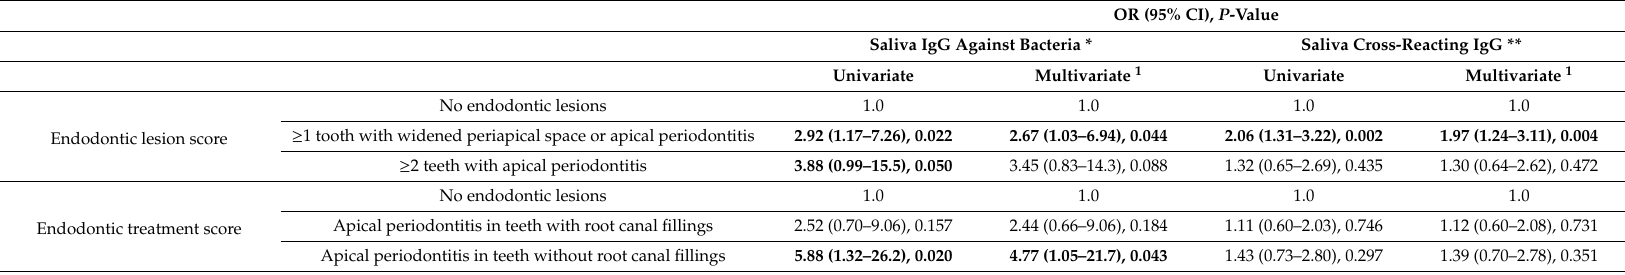
Table 4. Association of saliva IgG class antibody levels with endodontic scores in the subpopulation free from marginal